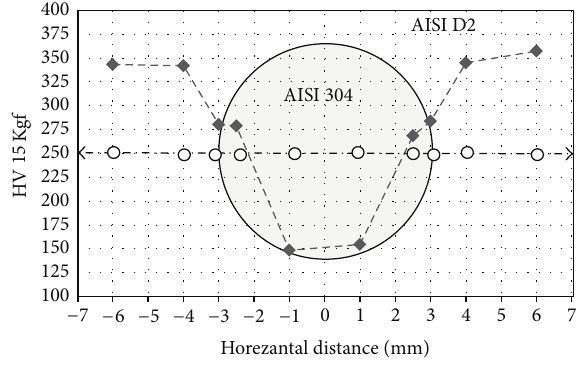
Figure 11: Vickers hardness